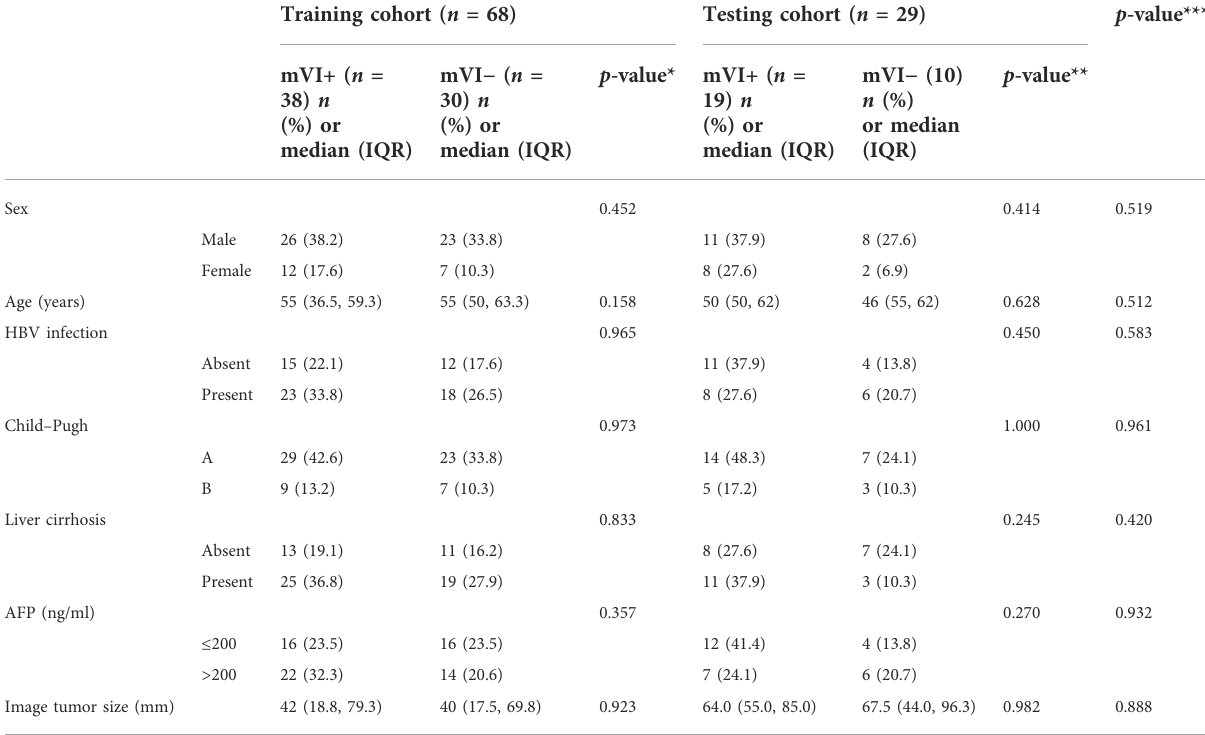
TABLE 1 Clinical characteristics of patients with HCC in the training and testing